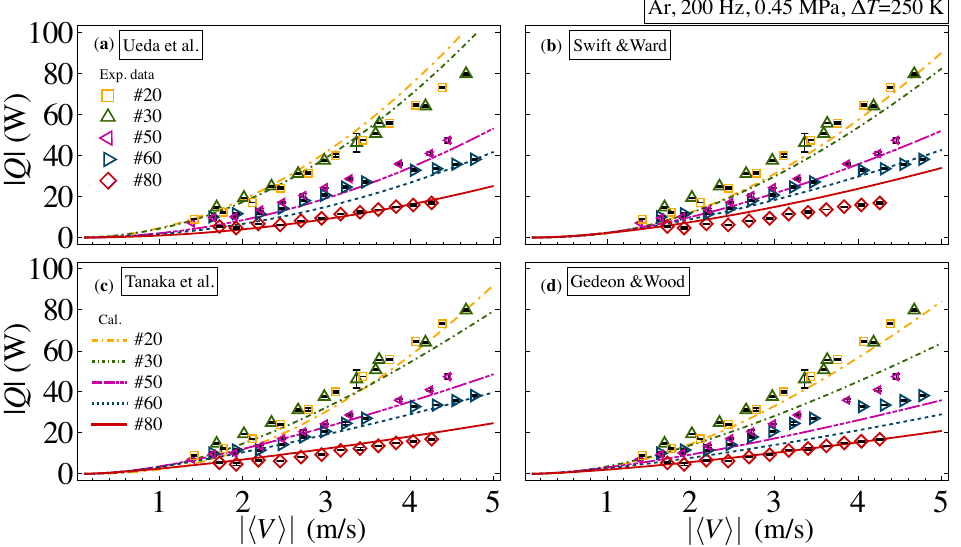
Q Figure 3. Experimental heat flow rate and predictions given by respective empirical equations | | cited in this study for stacked-screen regenerators tested in pressurized helium gas with 0.45 MPa and with oscillation frequency of 200 Hz. Each panel presents identical experimentally obtained results by symbols with error bars. The empirical predictions are given, respectively, as ( a ) for Ueda et al.; ( b ) for Swift and Ward; ( c ) for Tanaka et al.; and ( d ) for Gedeon and